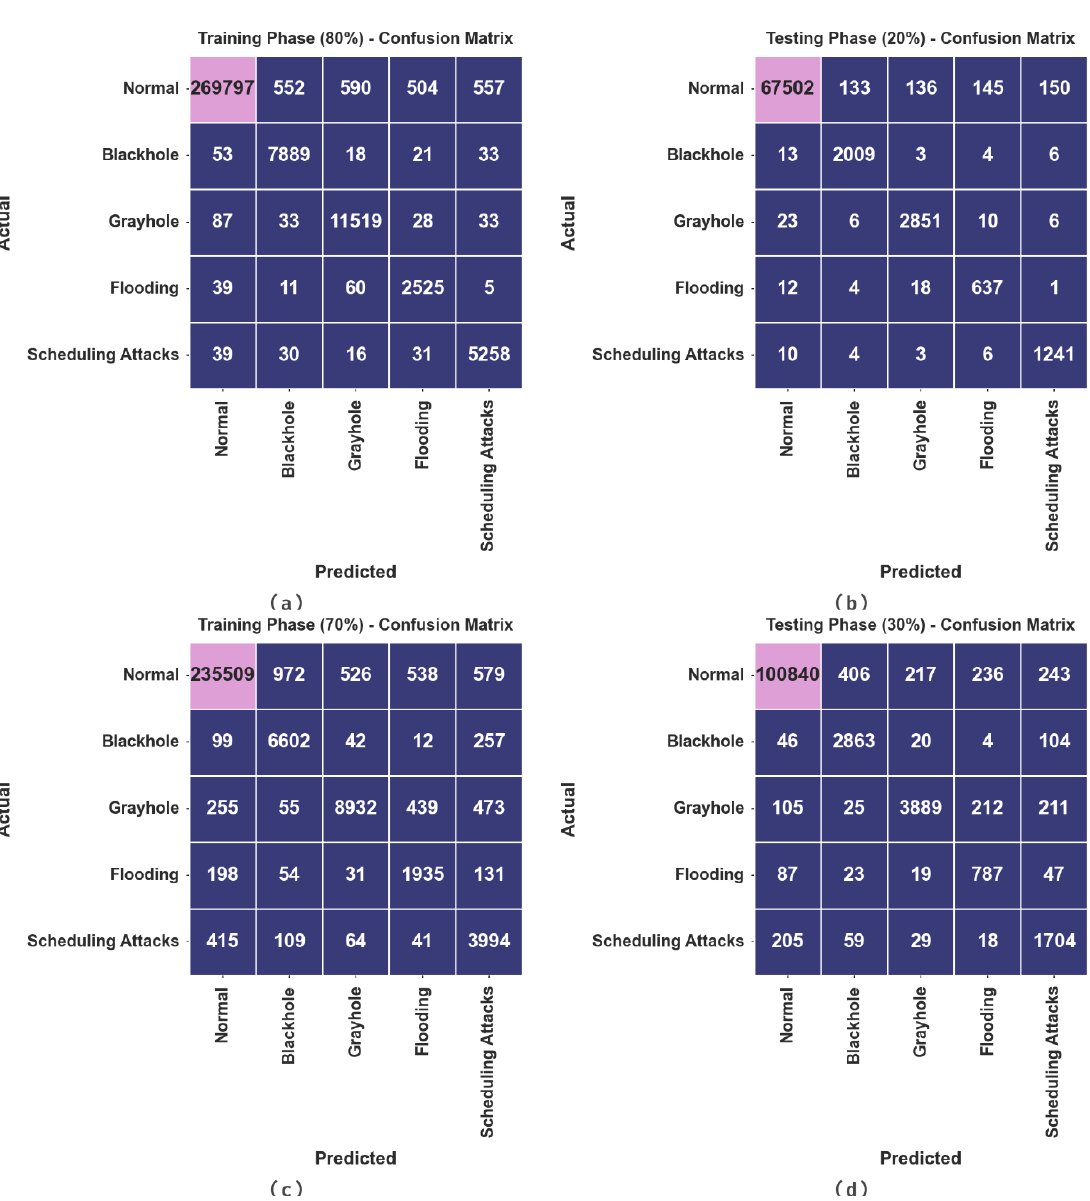
Figure 3. Confusion matrices of the BCOA-MLID approach ( a , b ) TRP/TSP of 80:20 and ( c , d ) TRP/TSP of 70:30.